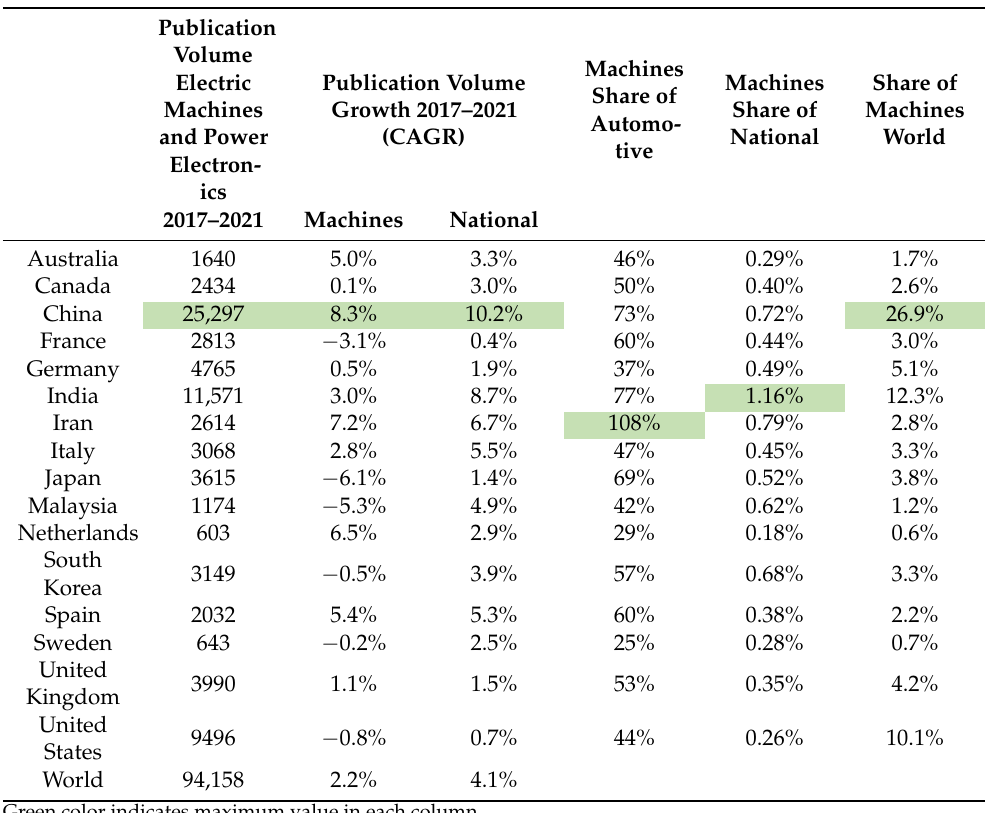
Table 5. Key indicators for electric machines and power electronics